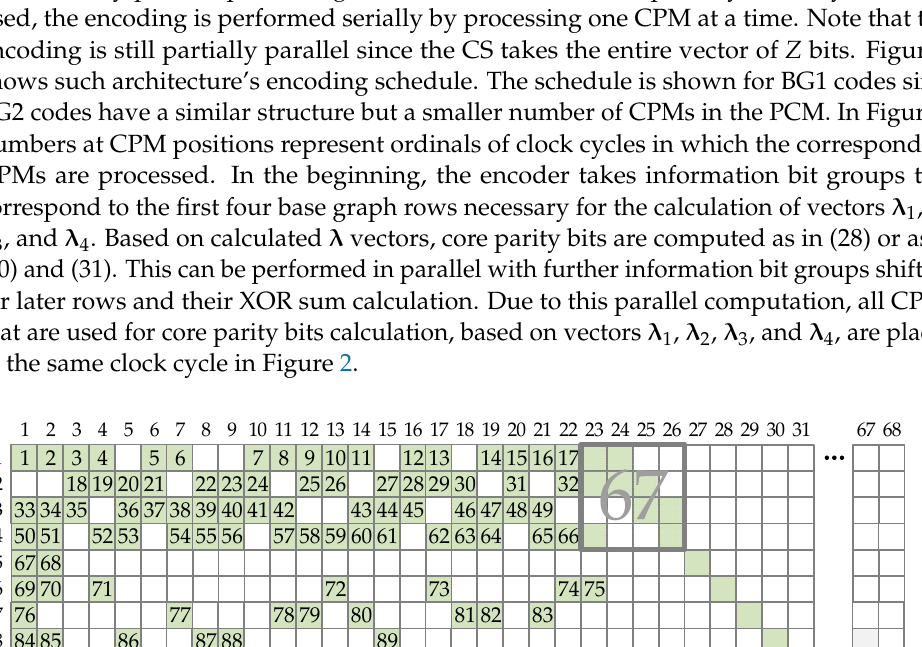
Figure 3. Encoding schedule for BG1 codes when processing the entire base graph matrix column at the same time. Numbers represent the ordinal of the clock cycle in which the corresponding CPM is processed.